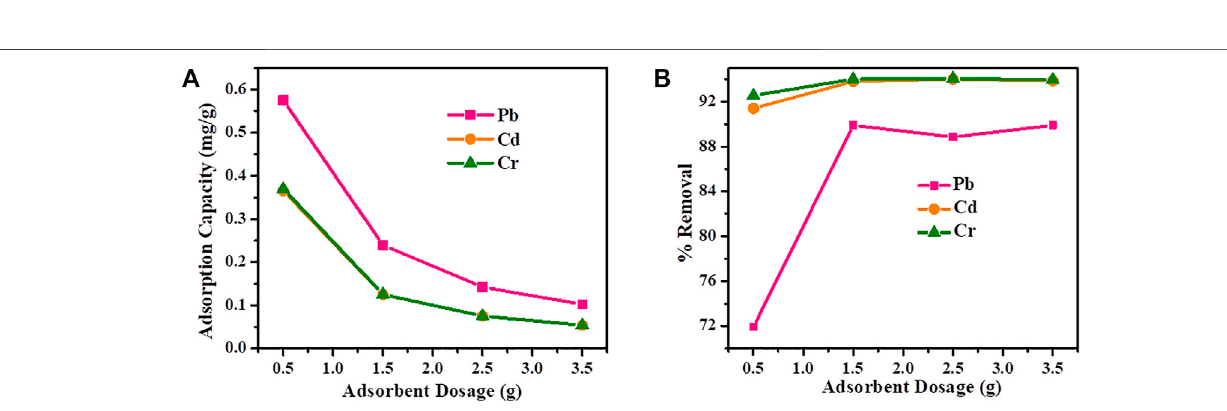
Frontiers in Materials |